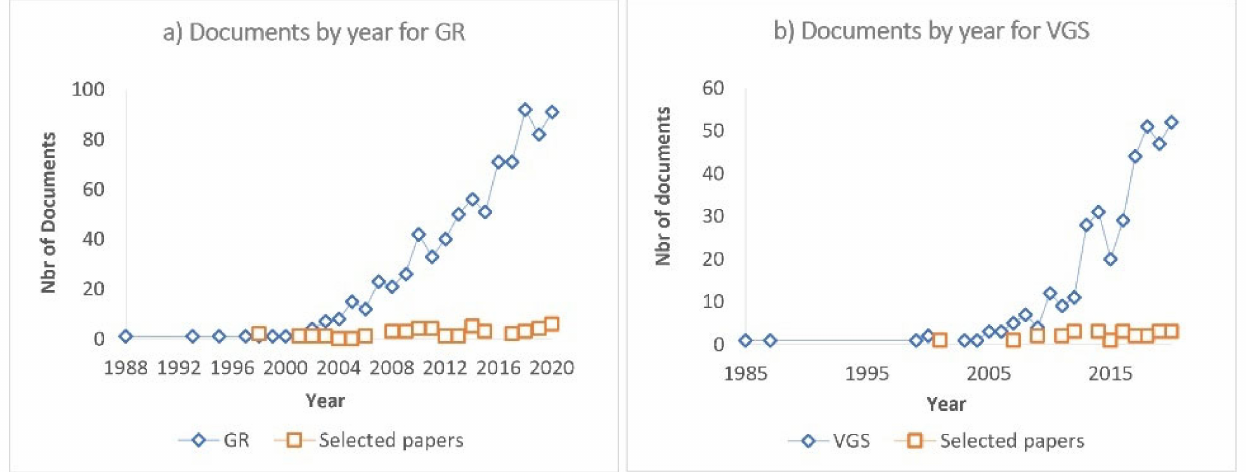
Figure 1. Publications by year of green roofs ( a ) and vertical greenery systems ( b ) compared to publications selected in our study (source; Scopus ®